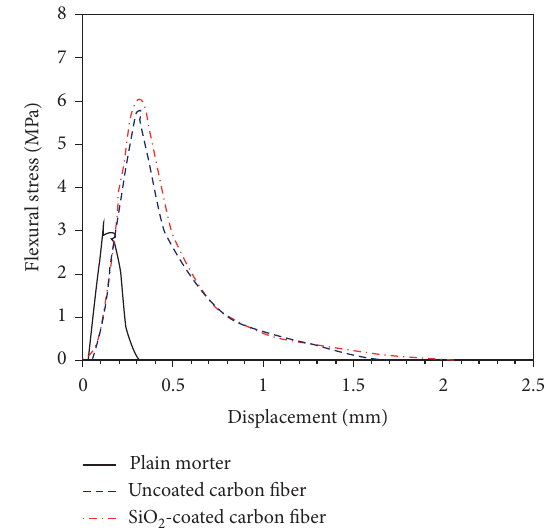
Figure 11: Flexural stress-displacement relationship